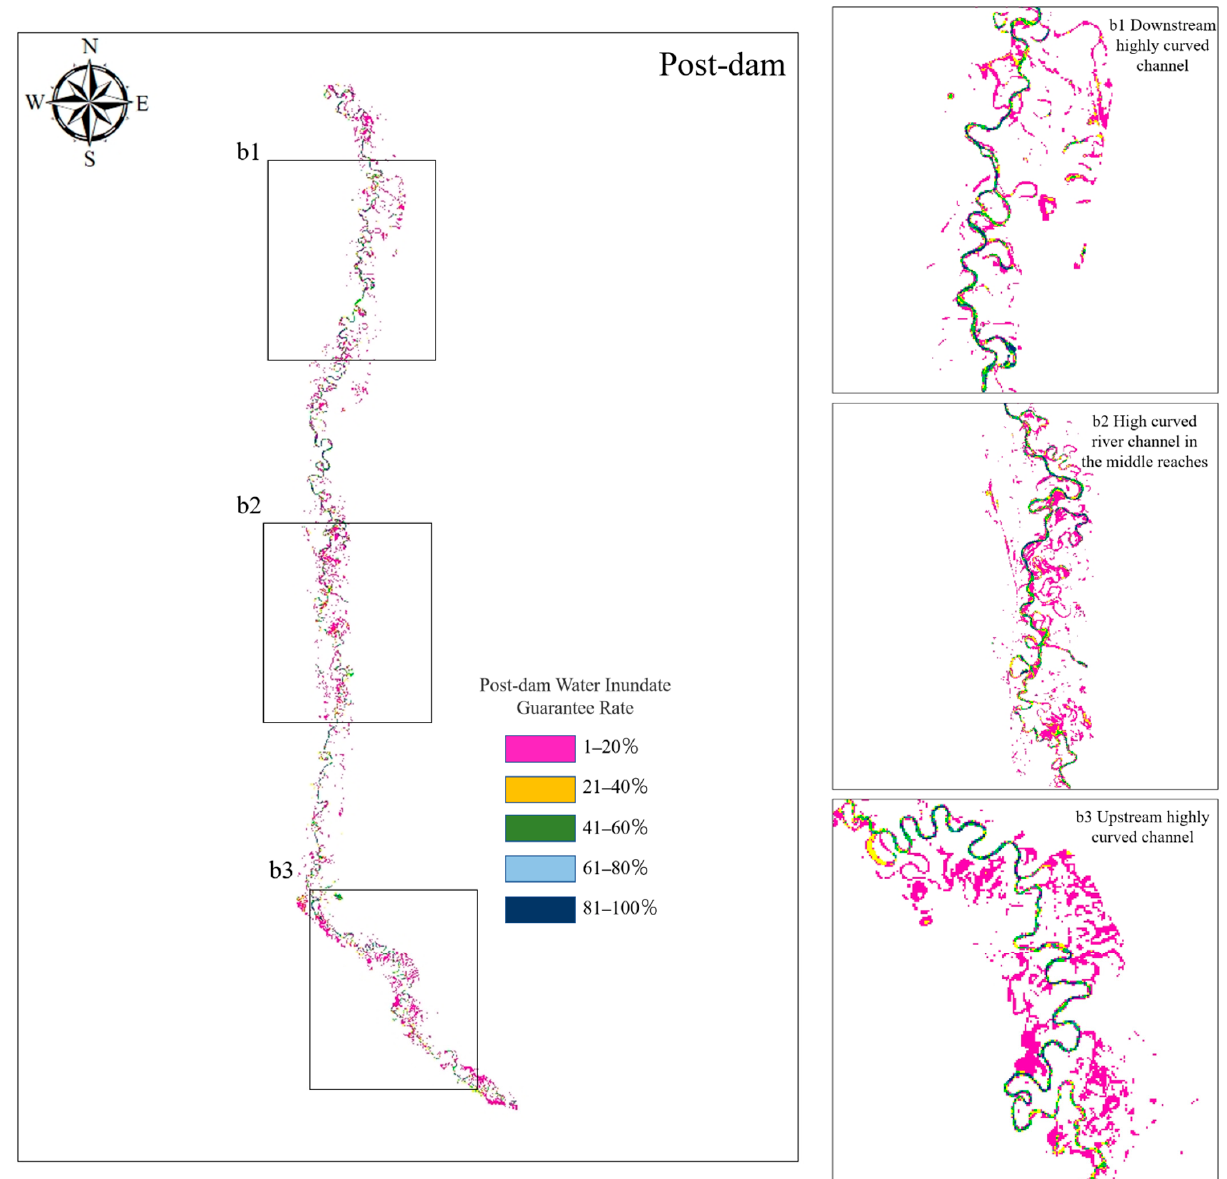
Figure 10. Post-dam Area distribution and typical change area under different inundation guarantee rates. Table 5. Typical regional variation area difference in WIGR.